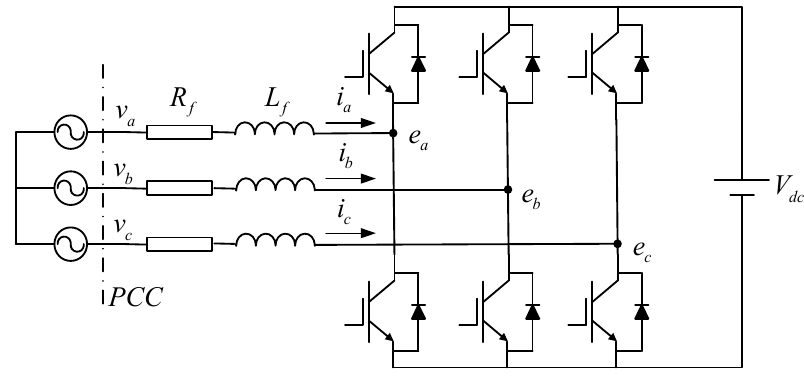
Figure 1. Topology of DC/AC converter.